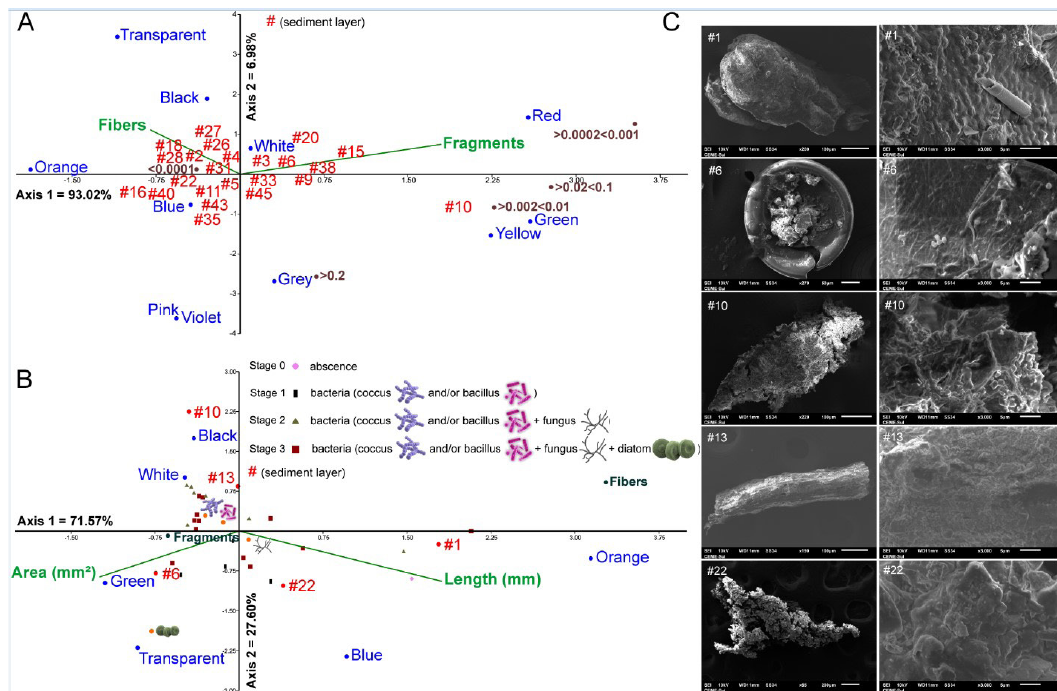
Figure 3. CCA ordination diagram showing MP composition. (A) Microbial biofilm association (plastisphere) regarding MP surface characteristics. (B) MEB plastisphere images for different layers (# cm) (65x and 270x magnification) and the biofilm (3000x magnification) (C) #1 left: coccus bacteria, #1 right: Aulacoseira granulata diatom, #6: coccus and bacillus bacteria, fungi and unidentified biological structure, #13: coccus bacteria, #22: coccus